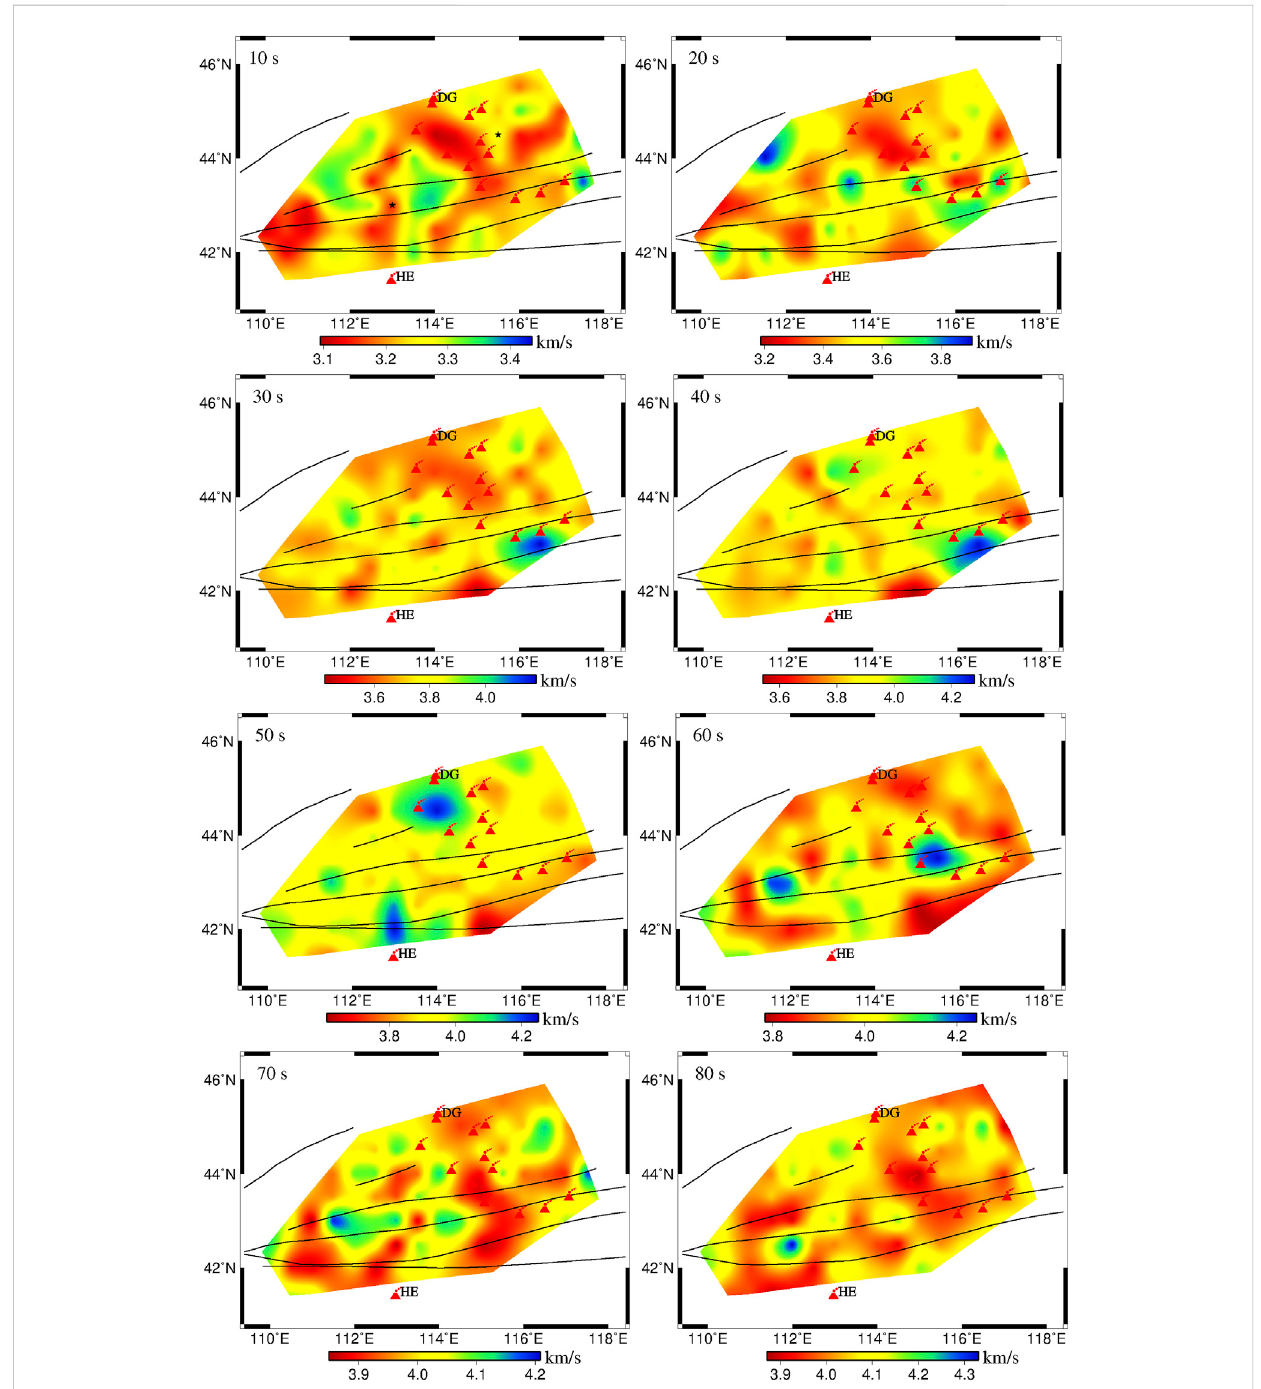
FIGURE 5 Phase velocity maps of Rayleigh-wave in the study region. The number in the upper left corner represents the period (s). The red triangles are the locations of the volcanoes, in which DG is the Dariganga volcano, HE is the Honggeertu volcano, and the rest red triangles are the Abaga volcano group. The black fi ve-pointed stars on 10 s pro fi le are the speci fi c locations of the two grid points used in Figure